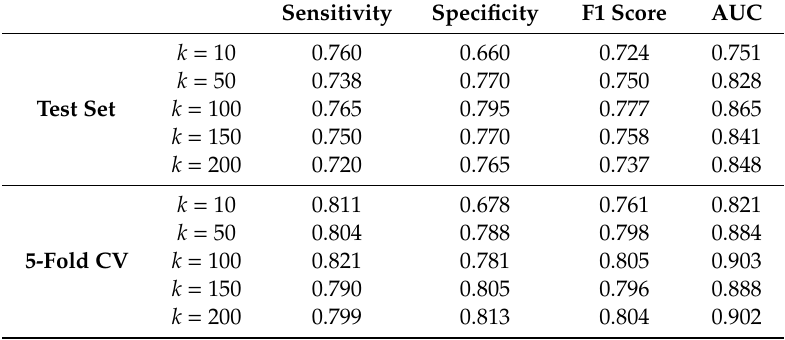
Table 3. Performance results of the support vector machine classifier for cluster detection validated with the external set and performing a 5-fold cross validation on the whole data for several k values of k -means tested in terms of sensitivity, specificity, F1 score, and AUC